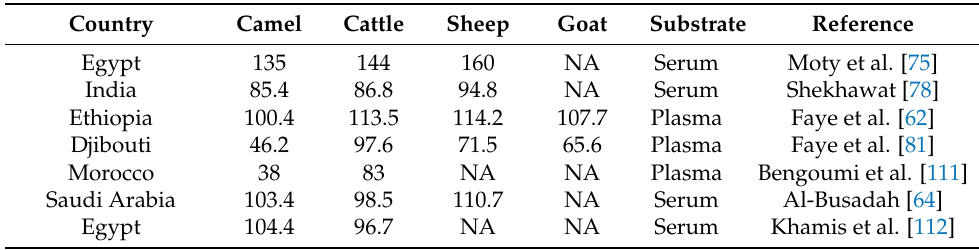
Table 2. Comparative mean concentrations of plasma or serum zinc in various species of domestic ruminants (in µ g/100